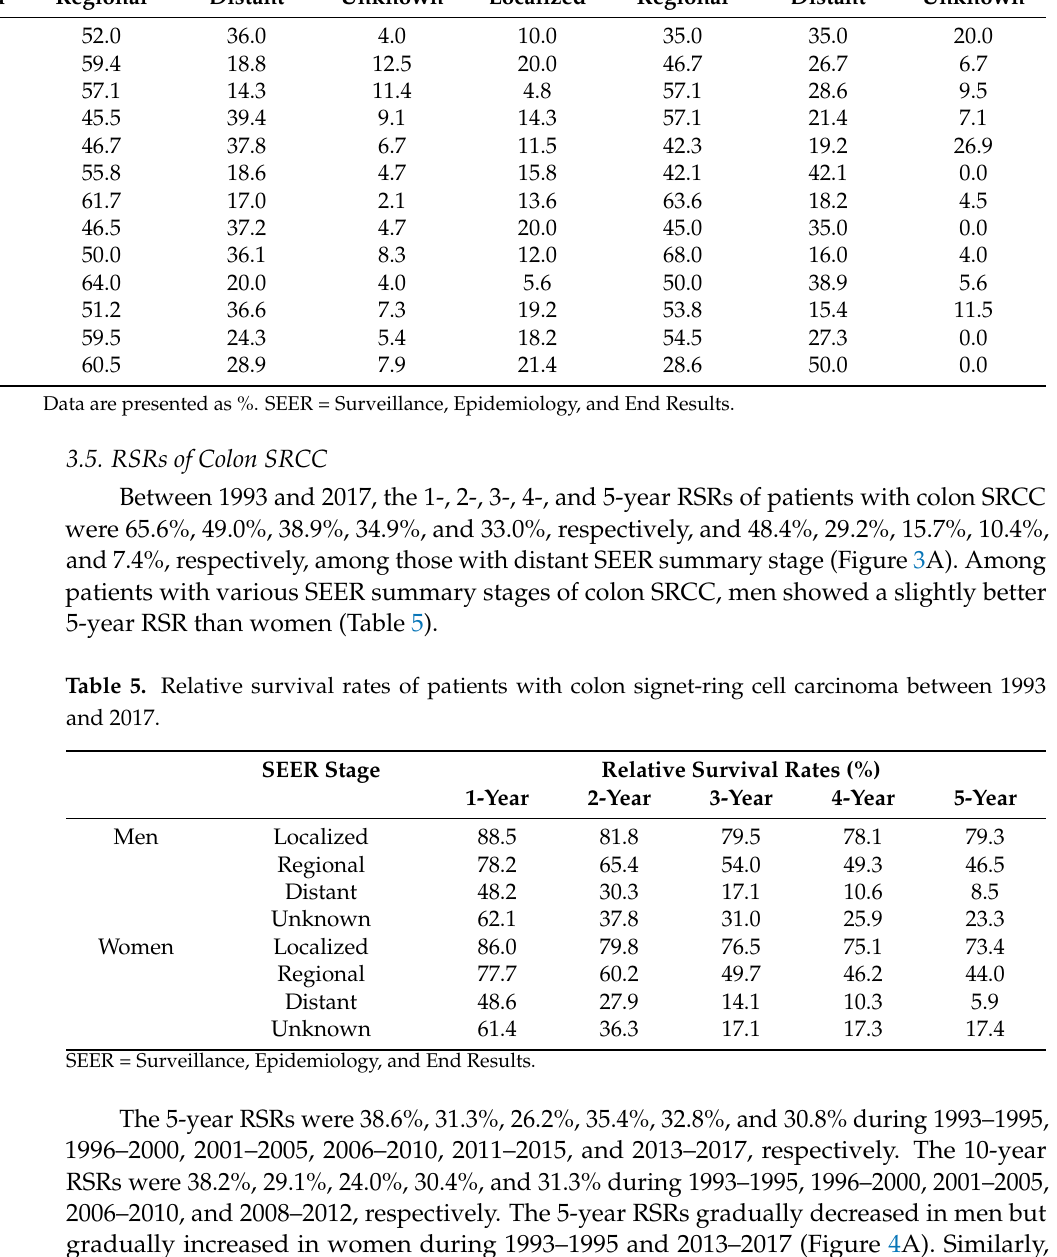
Table 4. SEER summary stages of rectum signet-ring cell carcinoma between 2005 and 2017.